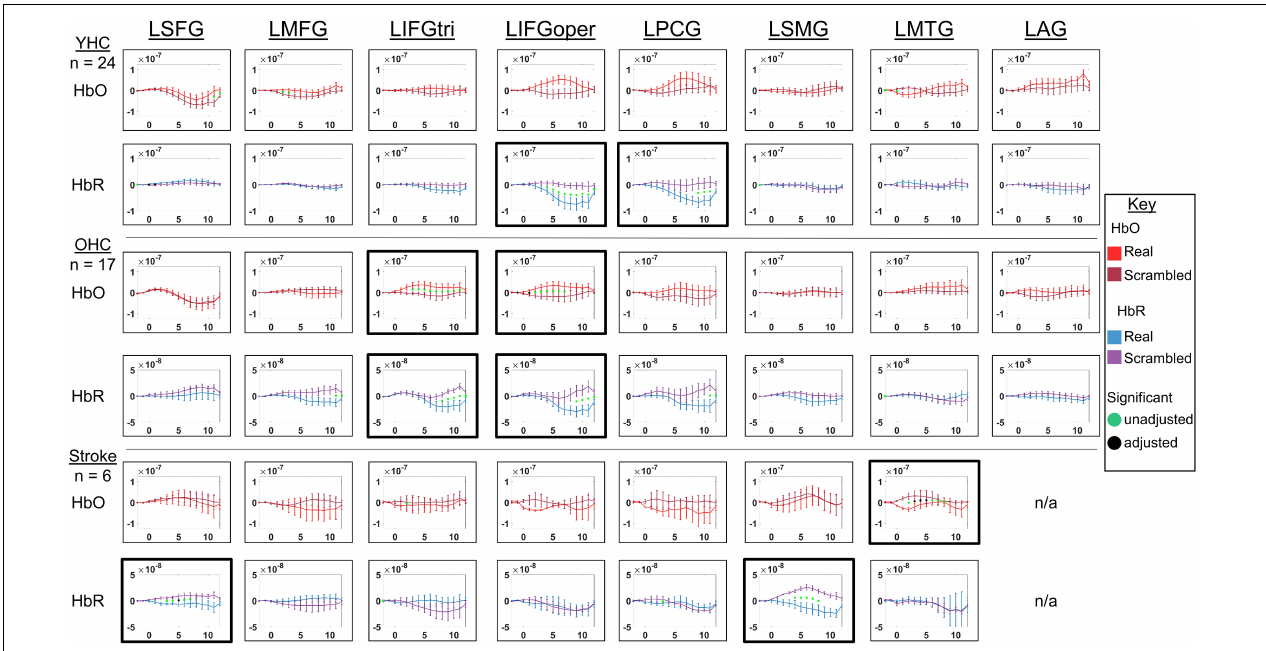
FIGURE 4 | Comparison of group average HRF between task conditions for left hemisphere ROIs during semantic feature judgment. HbO and HbR changes in µ M units. Significant difference between task conditions at p < 0.05 level are reflected by a green dot and after FDR-adjustment with alpha of 0.05 by a black dot. Black borders denote ROIs for which there was a significant difference between the task conditions for at least three consecutive seconds. When the red line is higher than the maroon line, it suggests there was greater HbO concentration change in the real than scrambled picture condition. When the blue line is lower than the purple line, it suggests there was lower HbR concentration change in the real than scrambled picture condition. Both patterns are consistent with greater neural activation (i.e., increase in oxygenated blood, decrease in deoxygenated blood) in the real than scrambled picture condition and vice versa. LSFG, left superior frontal gyrus; LMFG, left middle frontal gyrus; LIFGtri, left inferior frontal gyrus pars triangularis; LIFGoper, left inferior frontal gyrus pars opercularis; LPCG, left precentral gyrus; LSMG, left supramarginal gyrus; LAG, left angular gyrus; YHC, younger healthy controls; OHC, older healthy controls; HbO, oxygenated hemoglobin concentration change; HbR, deoxygenated hemoglobin concentration change, N/A, not available due to combination of pruned channels due to poor SNR and